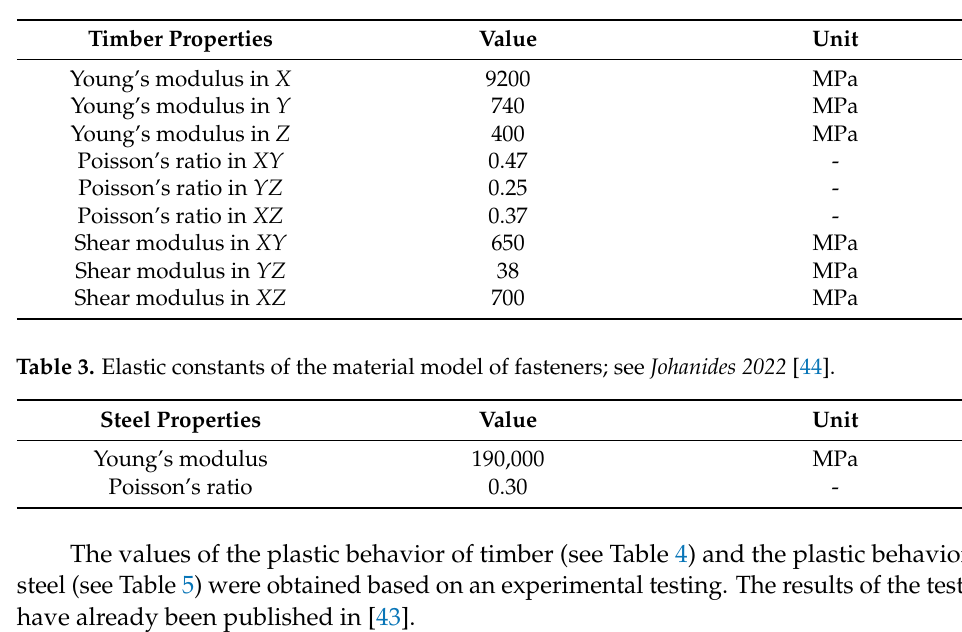
Table 2. Elastic constants of the material model for timber; see Johanides 2022 [44].